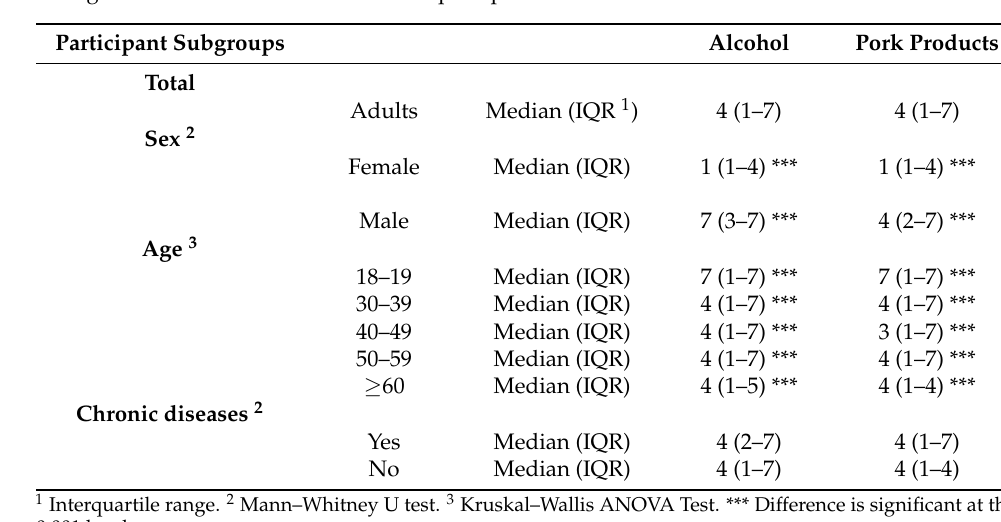
Table 3. Descriptive statistics for different participant subgroups concerning their acceptance of taking medicines that contain alcohol or pork products.